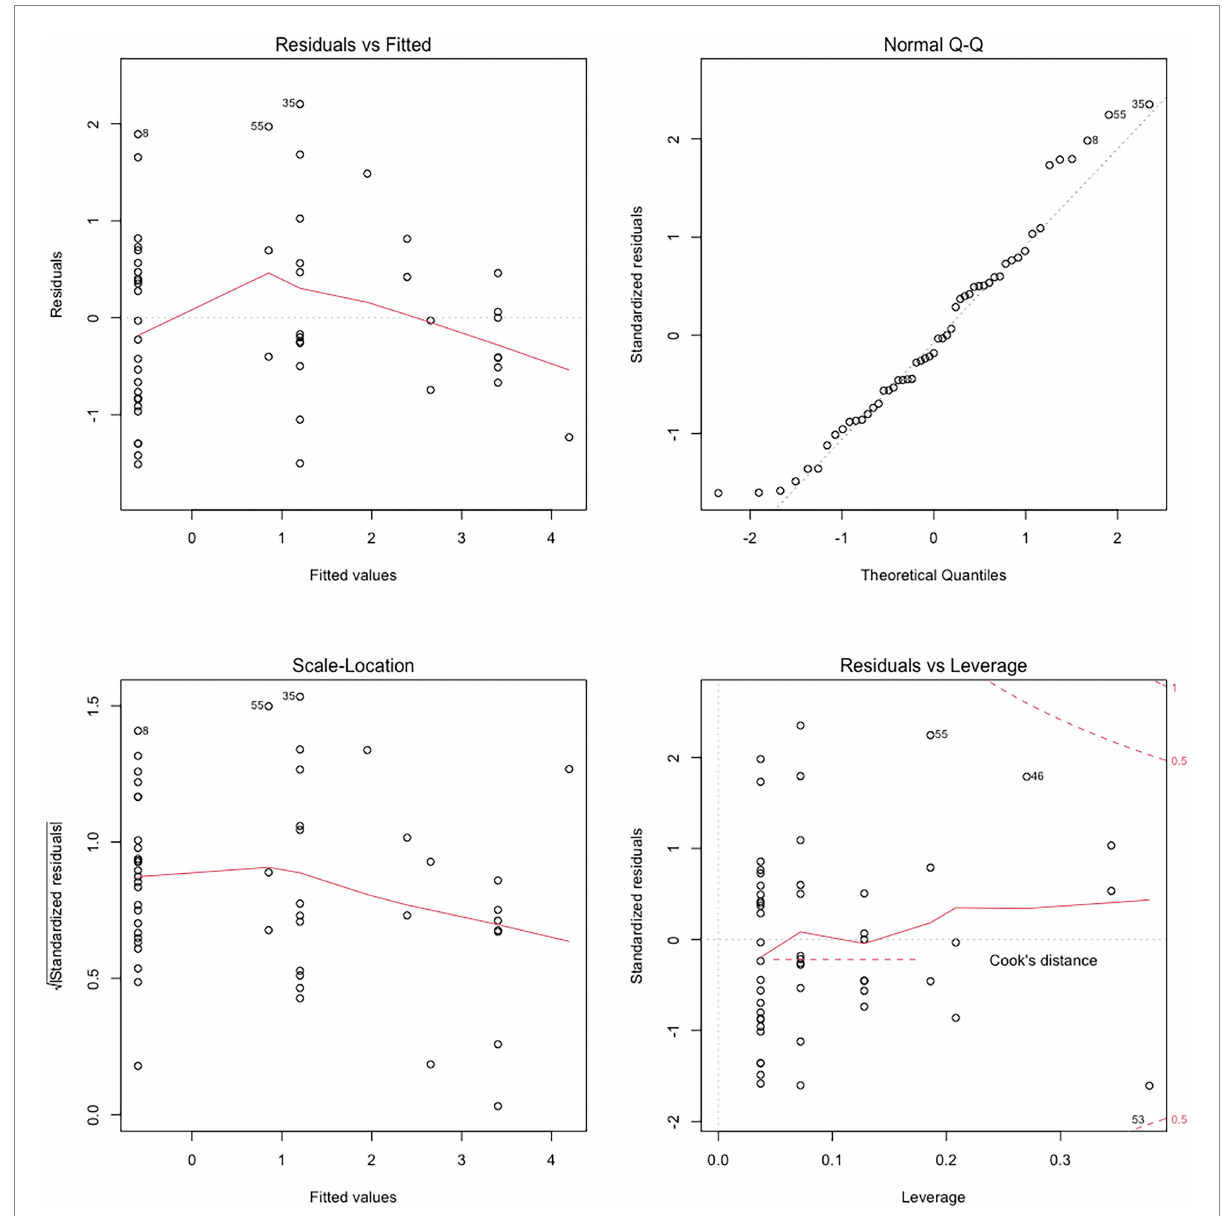
FIGURE 3 Four residual plots for regression Model 1 (cognitive requirements). The “Residuals vs. Fitted” plot (upper left) shows the fitted and unstandardized residual values. The “Normal Q-Q” plot illustrates the correct model specification and shows that the residuals are normally distributed. The assumption of homoscedasticity is shown in the “Scale-Location” diagram on the lower left. The outliers and influential values are shown on the plot “Residuals vs. Leverage” on the lower right (see also Luhmann, 2020, pp. 238–255; Field et al., 2012, pp.